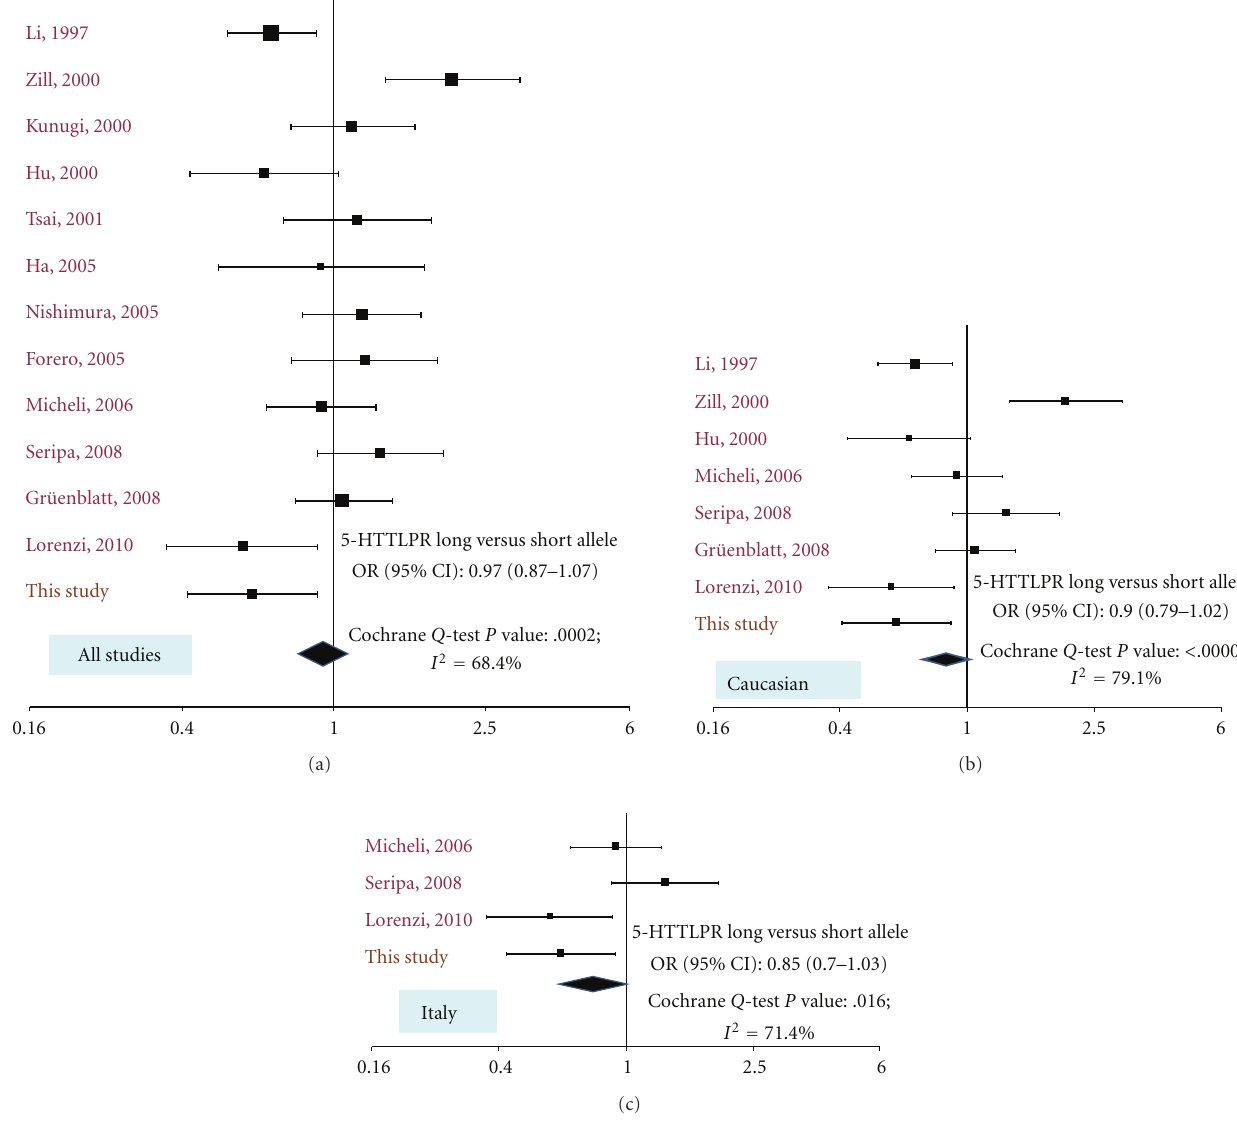
Figure 1: Meta-analysis of 5-HTTLPR . We have included our own data in three datasets: (a) all nonoverlapping studies regardless of ethnicity available online (http://www.alzforum.org/ [20]); (b) Caucasian studies only; (c) Italian studies only. The odds ratio (OR) and 95% confidence interval (CI) are calculated for the long (L) versus short (S) allele. The diamond is the output of meta-analysis calculation, with its OR (95%